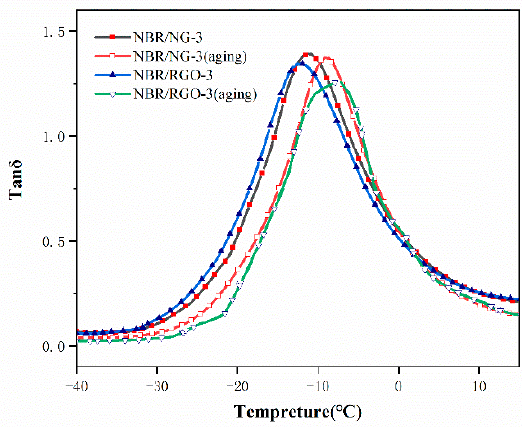
Figure 13. Loss factor (tan δ ) curves of NBR/RGO-3 and NBR/NG-3.